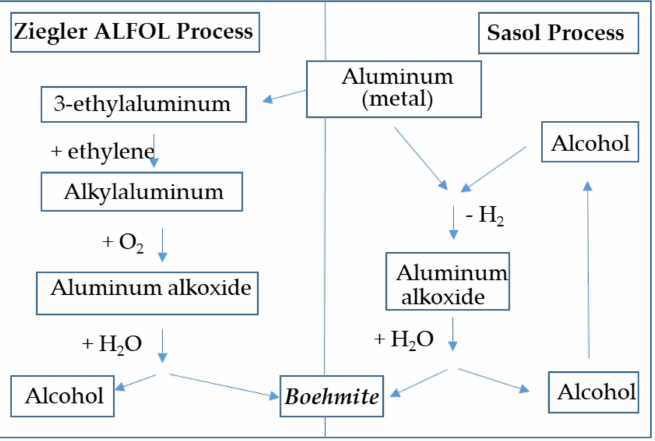
Figure 1. Scheme of boehmite synthesis using alcoholate technology